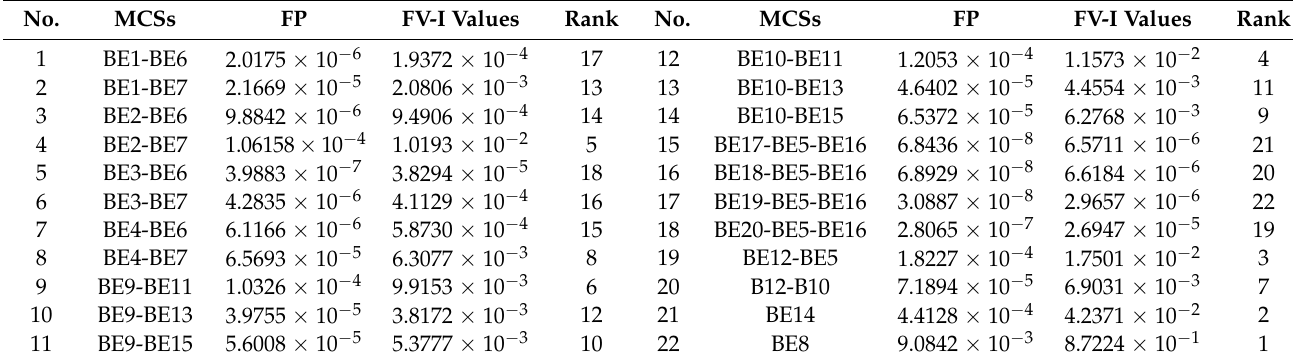
Table 9. FP and FV-I values of